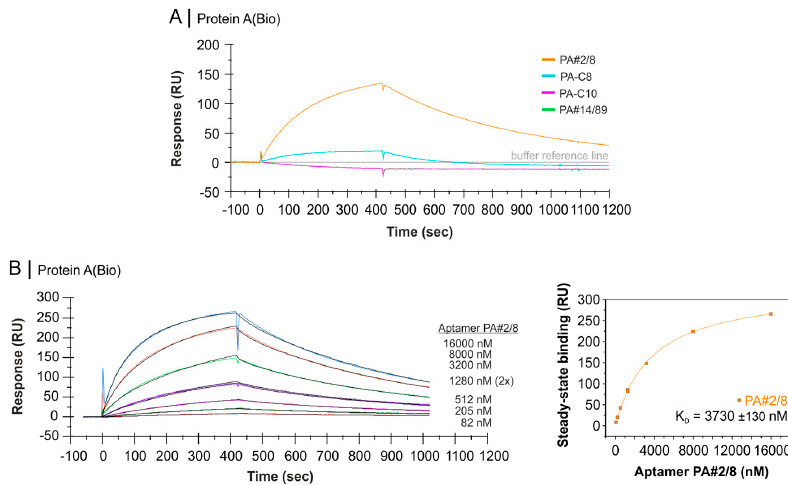
Figure 7. SPR-based interaction analyses with the Biacore X100 instrument applying aptamers as analyte. Biotinylated native Protein A was immobilized as ligand on the streptavidin-modified sensor surface. ( A ) Comparable binding analysis of unmodified candidate aptamers, 2000 nM each; ( B ) A concentration series of aptamer PA#2/8 was applied for binding. Black lines represent the fit to two state reaction model. The corresponding plot of steady-state binding data from the end of the association phases against analyte concentrations were used to calculate the steady-state affinity ( K D ).